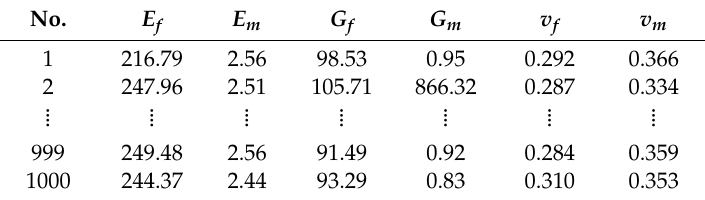
Table 6. Input data extraction for Monte Carlo Simulation of micro level.